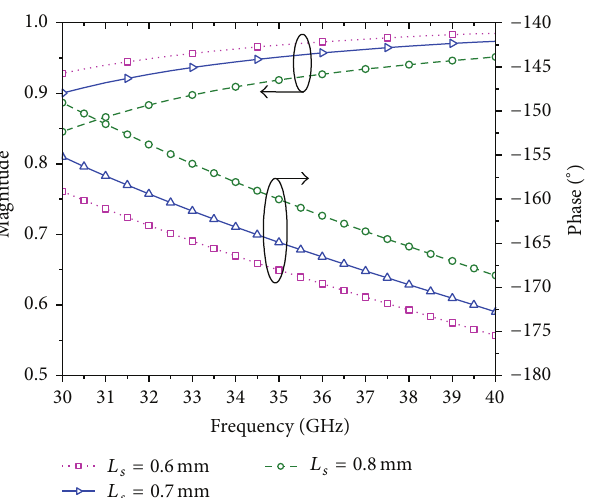
Figure 2: The reflection magnitudes and phases of the PRS cell.